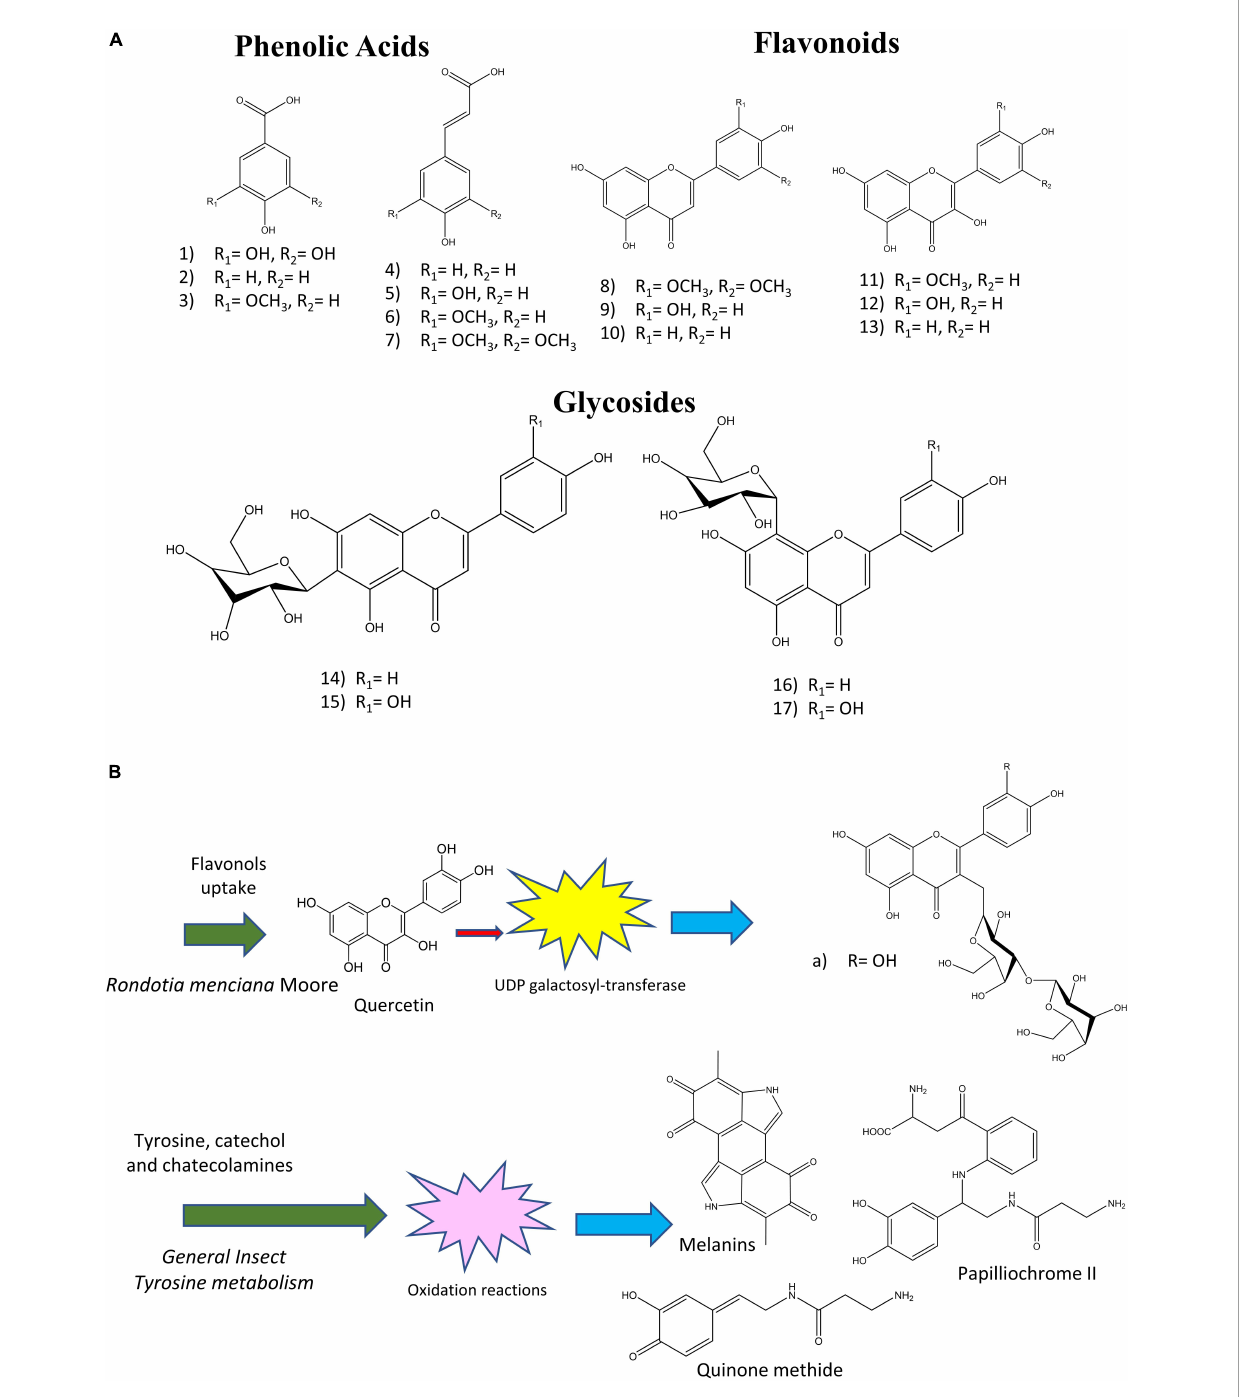
FIGURE1 (A) Common phenolic compounds reported in edible insects. (1) gallic acid, (2) 4-hydroxybenzoic acid, (3) syringic acid, (4) p-coumaric acid, (5) caffeic acid, (6) ferulic acid, (7) sinapic acid, (8) tricin, (9) luteolin, (10) apigenin, (11) isorhamnetin, (12) quercetin, (13) kaempferol, (14) isovitexin, (15) iso-orientin, (16), vitexin, (17) orientin (1). (B) Examples of reported processing of phenolic compounds absorbed by insects with its derivatives. (a) Quercetin 3-O- β -D-galactopyranosyl-(1 → 3)- β -D-galactopyranoside